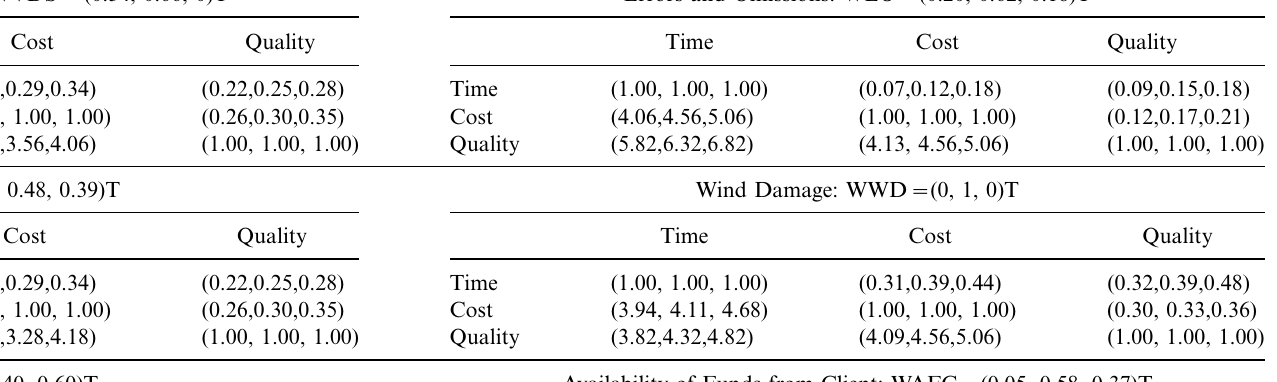
Table 7. (Level 4) Matrices of pairwise comparisons and respective normalized weigh vectors Vague/incomplete Design Scope: WVDS (cid:2) (0.34, 0.66,